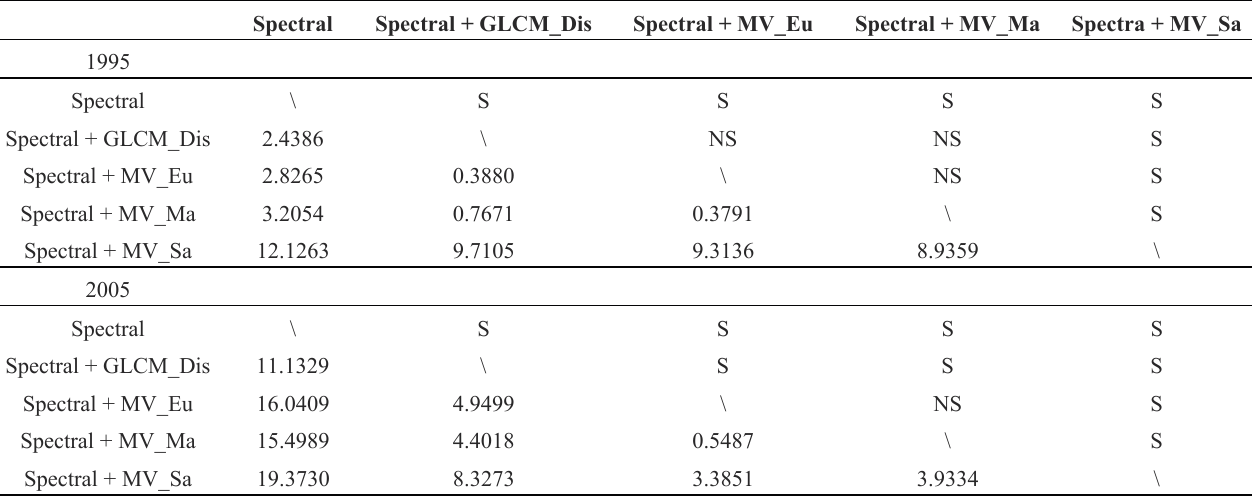
Table 5. The |(cid:1852)| values from McNemar’s test for the comparison of kappa coefficients from different classification results of Beijing images and corresponding statistical significances (at the 95% confidence